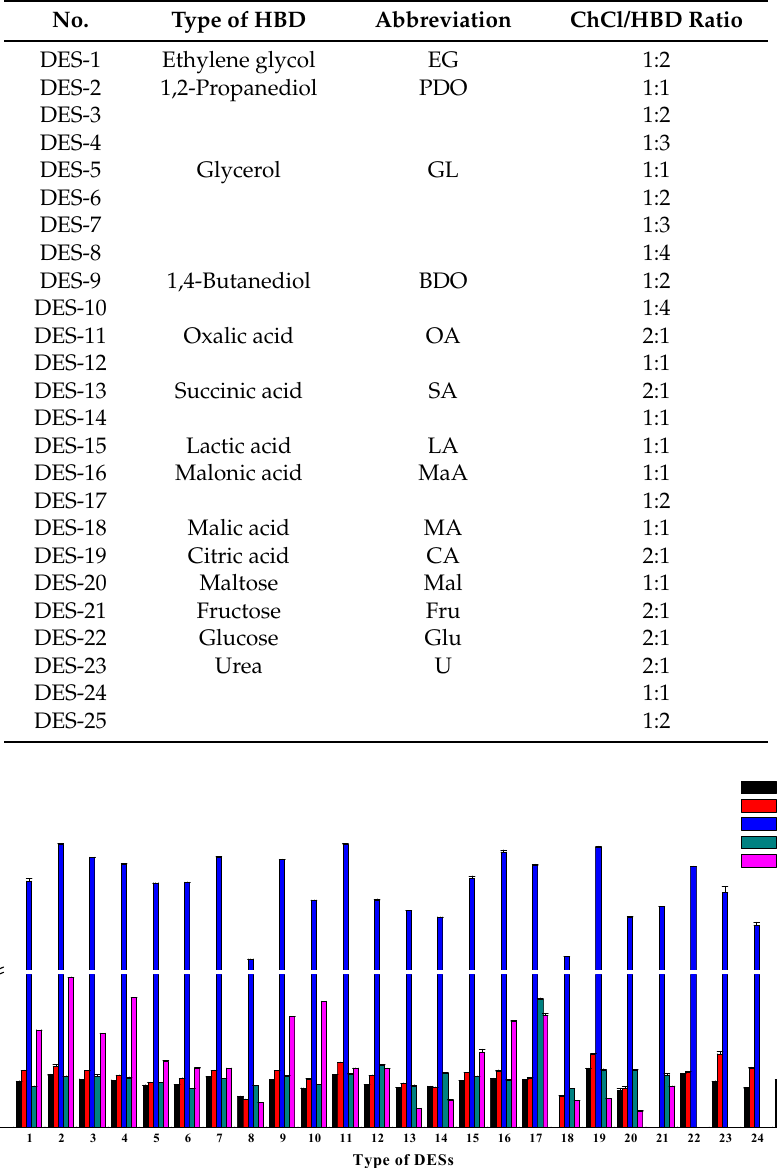
Figure 1. Effect of different types of DESs (temperature = 50.0 ◦ C, time = 10.0 min, microwave power = 800 W, solid/liquid ratio = 0.005 g · mL − 1 ).